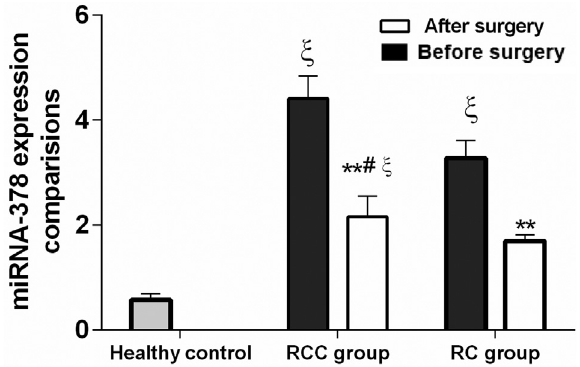
Figure 1 - Comparison of miRNA-378 expressions among healthy con- trols, renal cyst (RC) and renal cell carcinoma (RCC) patients before sur- gery and six months after surgery. ** p < 0.01 compared with before sur- gery in same group; # p < 0.05, compared with RC group after surgery. (cid:6) P < 0.01 compared with healthy subjects.